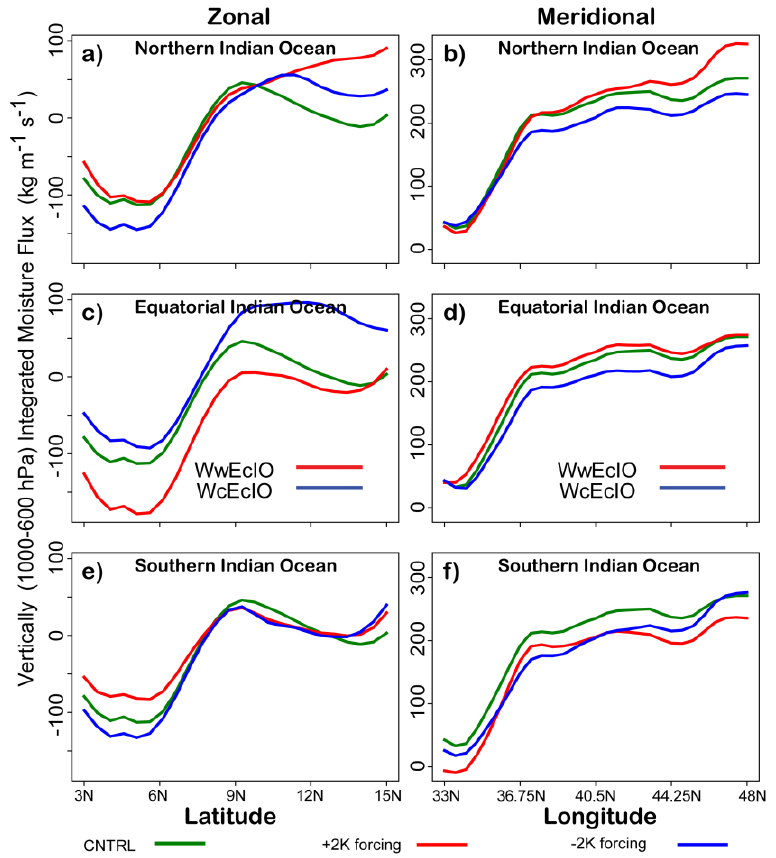
Figure 6. Vertically (1000–600 hPa) integrated zonal and meridional moisture fluxes averaged over July–August for warmer/cooler sea surface temperature (SST) anomaly forcing across the Indian Ocean. ( a ) Zonal moisture fluxes for the Northern Indian Ocean warming/cooling experiments. ( b ) Same as (a) except for meridional fluxes. ( c ) Zonal moisture flux for the linearly eastward decreasing/increasing SST forcing experiments over the Equatorial Indian Ocean. ( d ) Same as (c) except for meridional fluxes. ( e ) Same as (a) except for the Southern Indian Ocean (SIO). ( f ) Same as (b) except for the SIO. CNTRL is 10-member ensemble average obtained by specifying monthly varying 1971–2000 SST climatology with initial and boundary conditions obtained from 6-hourly and daily varying NCEP-NCAR Reanalysis climatology for 1971–2000. WwEcIO and WcEwIO are simulations with west-to-east linearly decreasing (increasing) ± 2K SST anomaly forcing. See Table 1 for description of